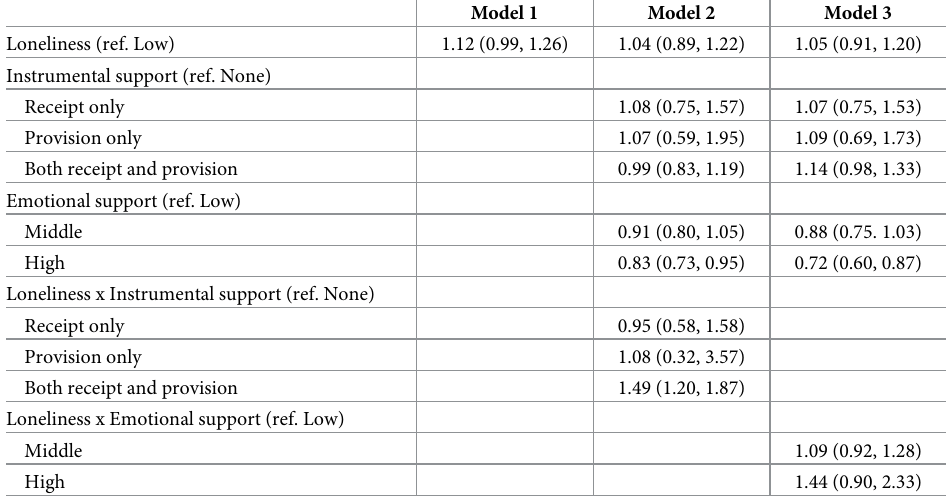
Table 2. Results of Poisson regression model with robust variance estimator examining the association between loneliness, social support and hypertension among rural community dwellers in Fujian Province, China (n =